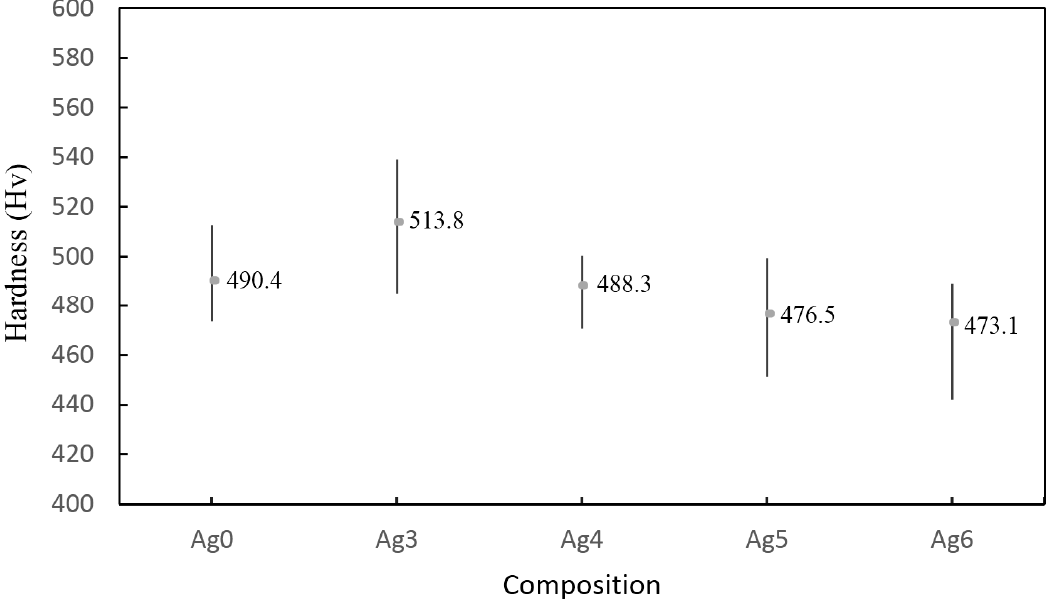
Figure 5. The hardness of the Cu 50 − x Zr 43 Al 7 Ag x alloys with increasing microalloyed Ag content.